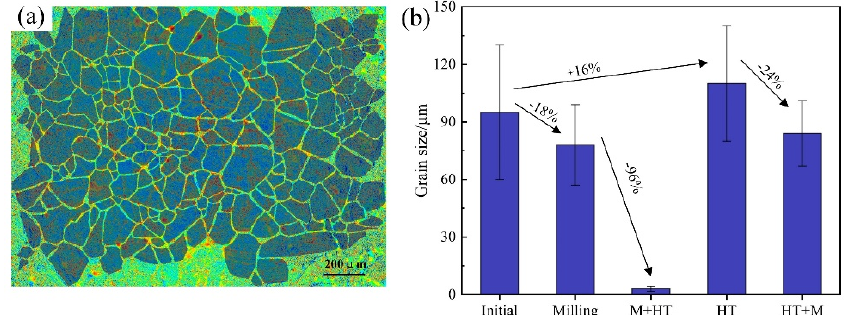
Figure 5. The surface grain size generated in the sequential production process: ( a ) the processed surface; ( b ) the grain size.